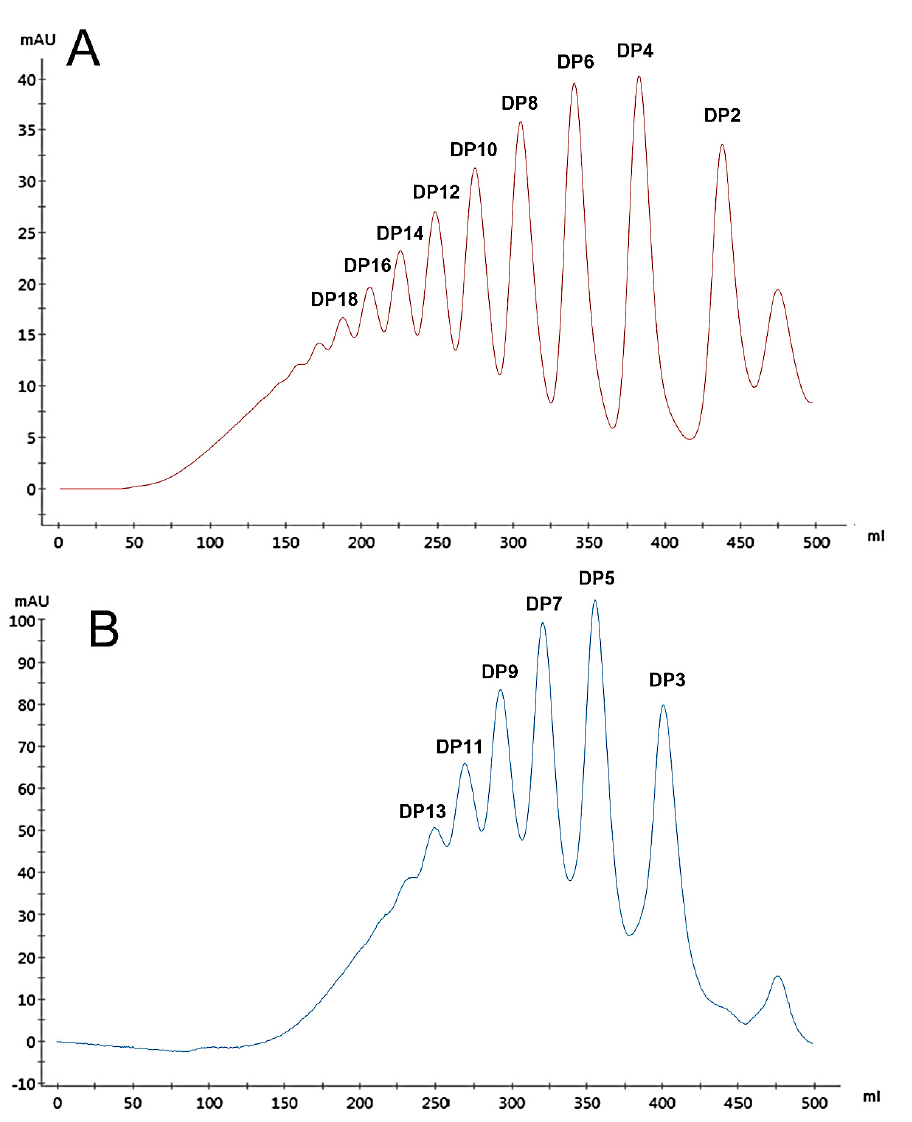
Figure 1. Hyaluronic acid oligosaccharide 1 (HAO1) ( A ) and HAO2 ( B ) were fractionated by gel exclusion chromatography on a Bio-Gel P10 column. Table 1. Summary of the results of ESI-MS and HPLC measurements of HAOs.